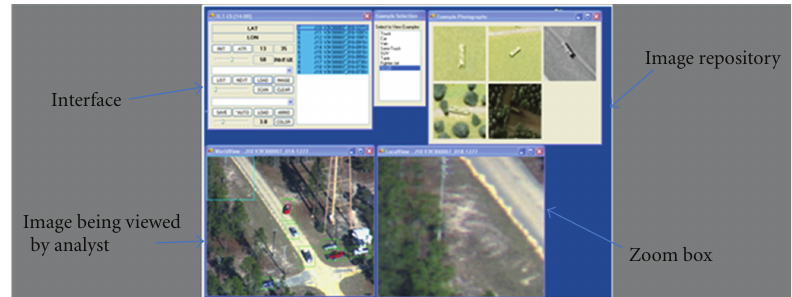
Figure 2: Display of example smages of SCUD.